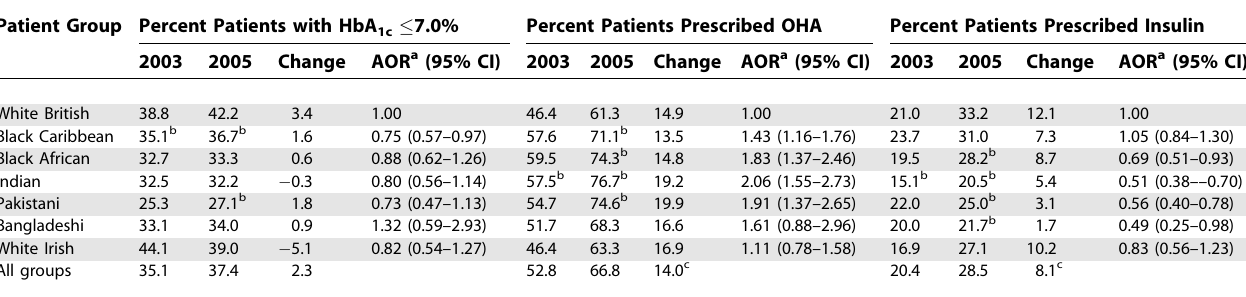
Table 1. Ethnic Disparities in Glycaemic Management and Control Patient Group Percent Patients with HbA 1c (cid:2) 7.0% Percent Patients Prescribed OHA